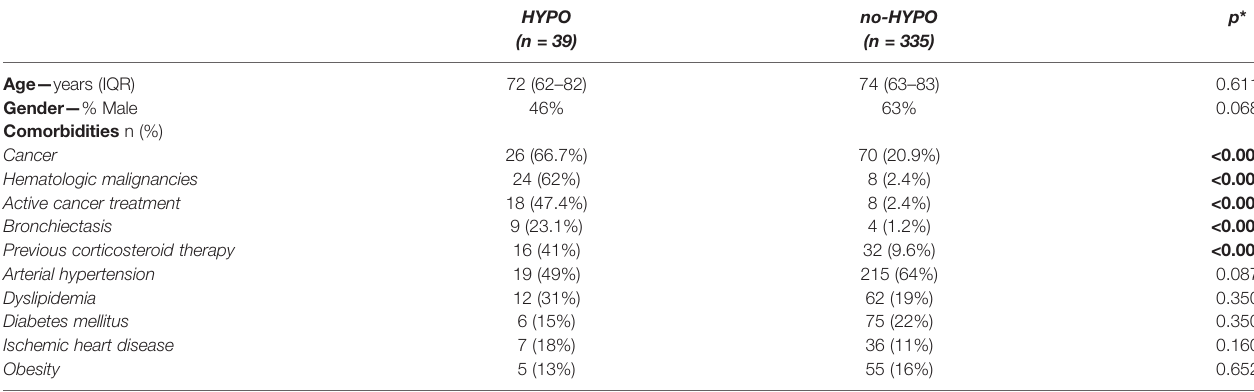
TABLE 1 | Demographics and comorbidities between HYPO vs. no-HYPO in our COVID-19 cohort.